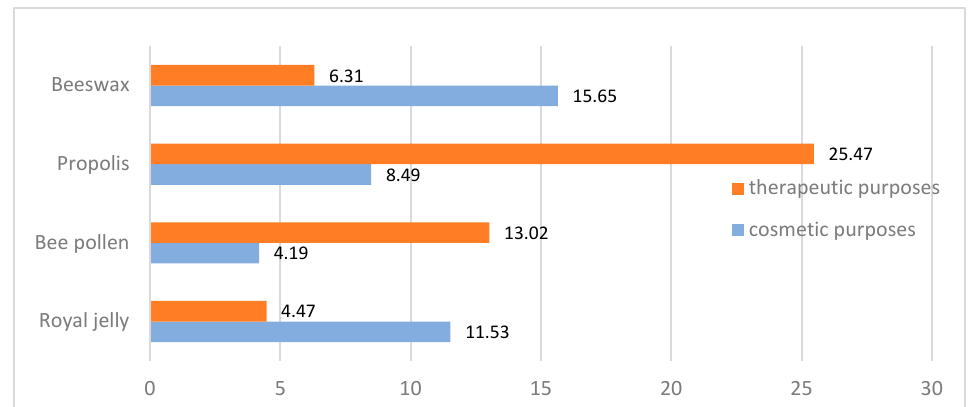
Figure 2. Use of wax, propolis, royal jelly, and bee pollen for cosmetic and medicinal purposes (n = 487, data in %).